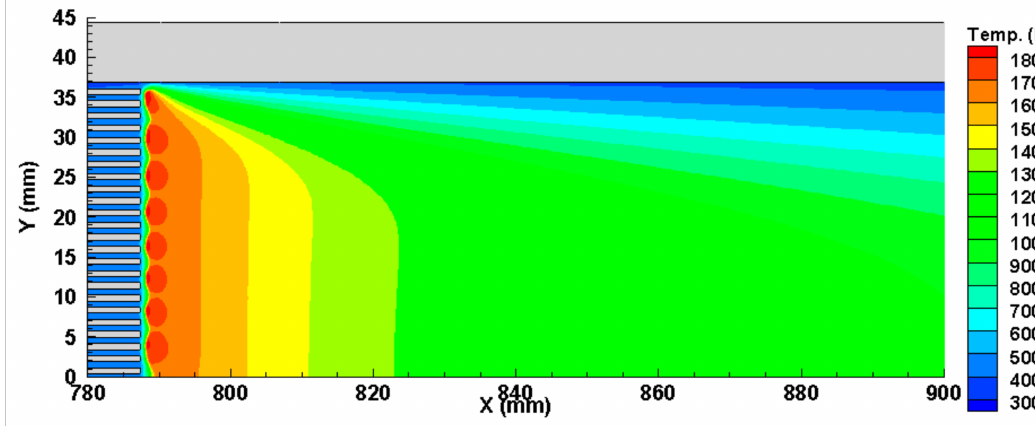
Figure 5. Temperature contour plots of the flame stabilizer channels and flame zone.